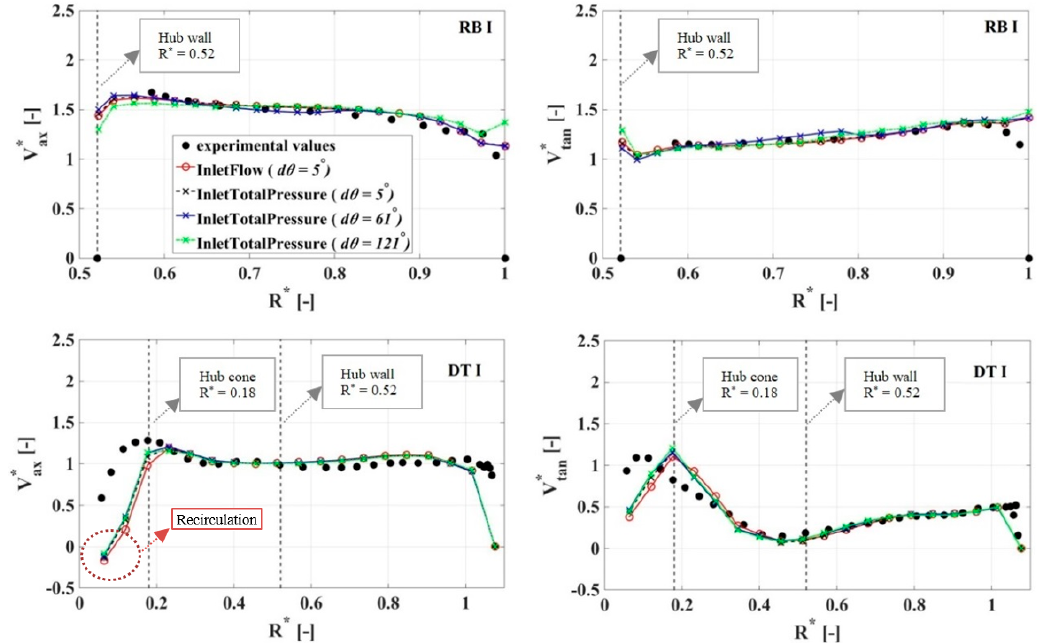
Figure 6. Experimental and simulated axial ( V ax * ) and tangential ( V tan * ) velocity at the BEP, in the runner blade channel (Section RB I) and below the runner hub (Section DT I). The dotted vertical lines represent the hub wall and